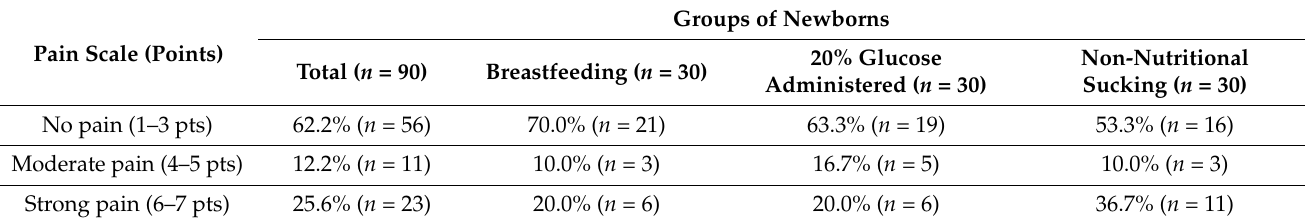
Table 1. Assessment of pain in newborns by intervention group.